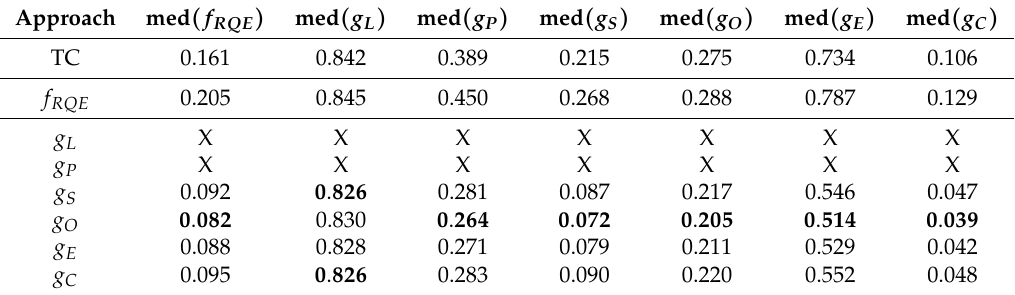
Figure 7. Real data results on the small-scale indoor dataset. The self-calibrations based on the features of omnivariance g O , eigenentropy g E and change of curvature g C lead to sharper point clouds compared to the target calibration. Table 1. Comparison of the median of the RQE (med ( RQE ) ) and the redefined features (med ( g L ) , ..., med ( g C ) ) for different calibration approaches. TC is the target calibration based on RADLOCC. RQE is the self-calibration based on the RQE. g L , ..., g C are the self-calibrations based on the corresponding feature. Lower feature values are better. The lowest feature value in each column is marked in bold. X: Calibration failed. The calibration based on the RQE leads to slightly higher values than the TC. The self-calibrations based on g S , g O , g E and g C outperform the TC and the calibration based on RQE . Omnivariance g O achieves the best